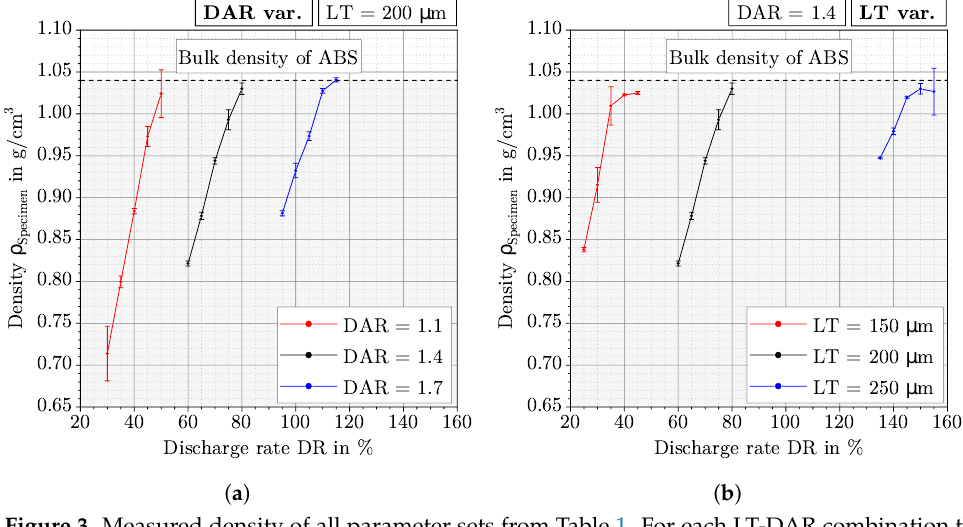
Figure 3. Measured density of all parameter sets from Table 1. For each LT-DAR combination the DR is changed in a range of 20%. The mean value and one standard deviation of the density are given for each parameter set. The bulk density for ABS is indicated by a horizontal line. ( a ): Density measurements for different DAR at constant LT. ( b ): Density measurements for different LT at constant